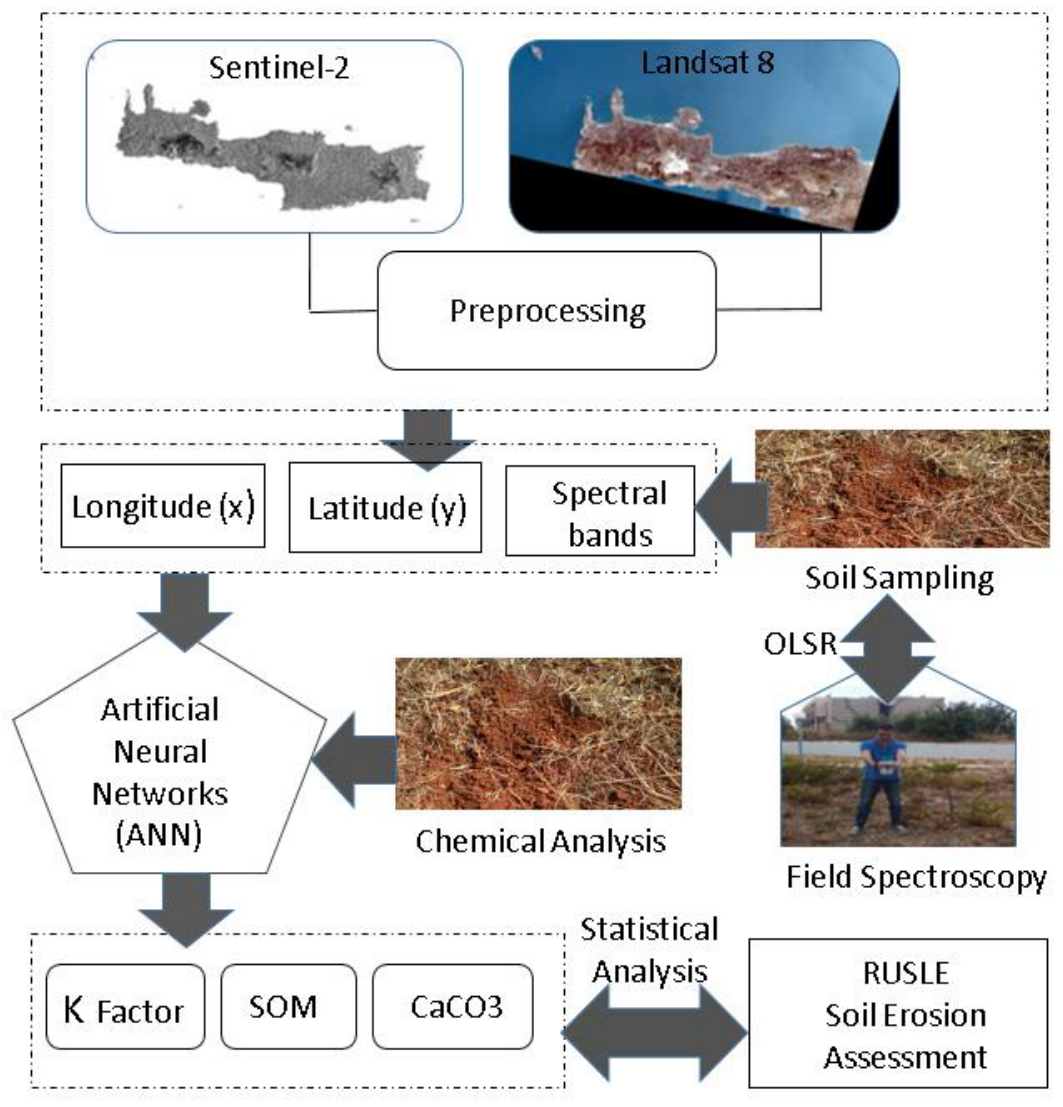
Figure 4. Flowchart of the overall methodology .